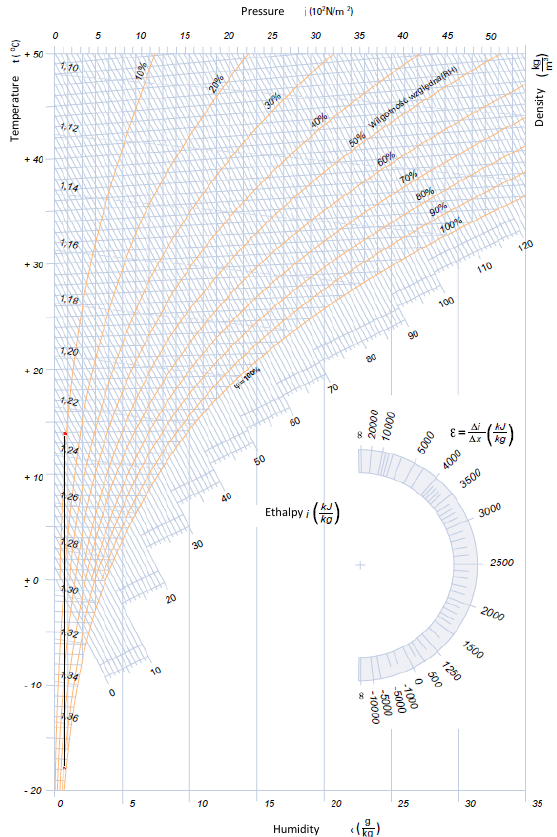
Fig. 9. Air process heating on Mollier chart ( x